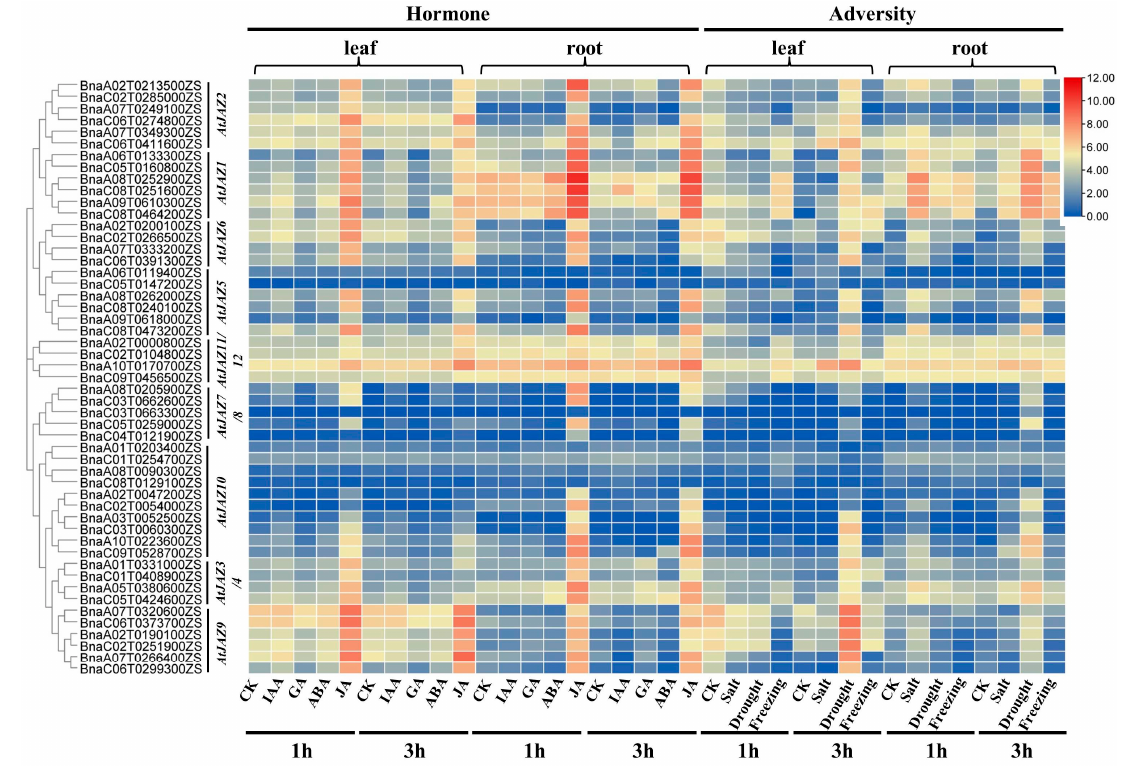
Figure 4. Expression patterns of 51 BnaJAZs under abiotic stress. The expression level of BnaJAZs in leaves and roots after 1 h and 3 h of treatment with various hormones and adversities. The homologous genes of BnaJAZs in Arabidopsis are displayed at the right of BnaJAZs . The type and time of treatments are shown at the bottom of the expressional heat map. The tissues of the samples were on the top of the expressional heat